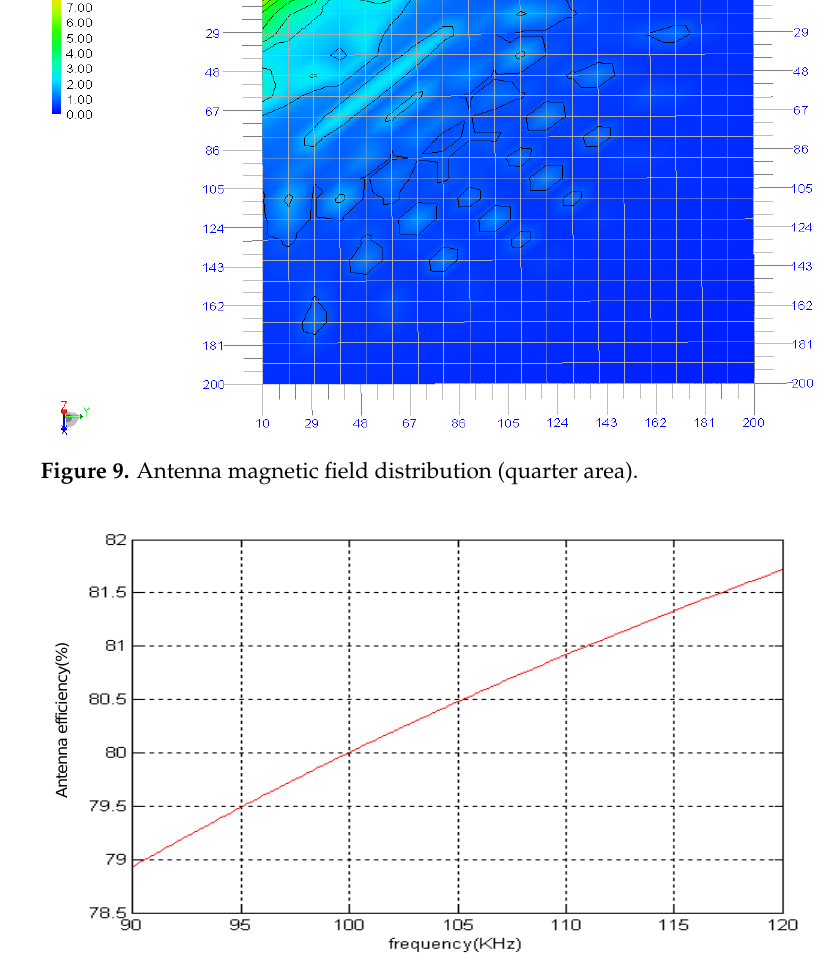
Figure 10. Antenna efficiency curve.